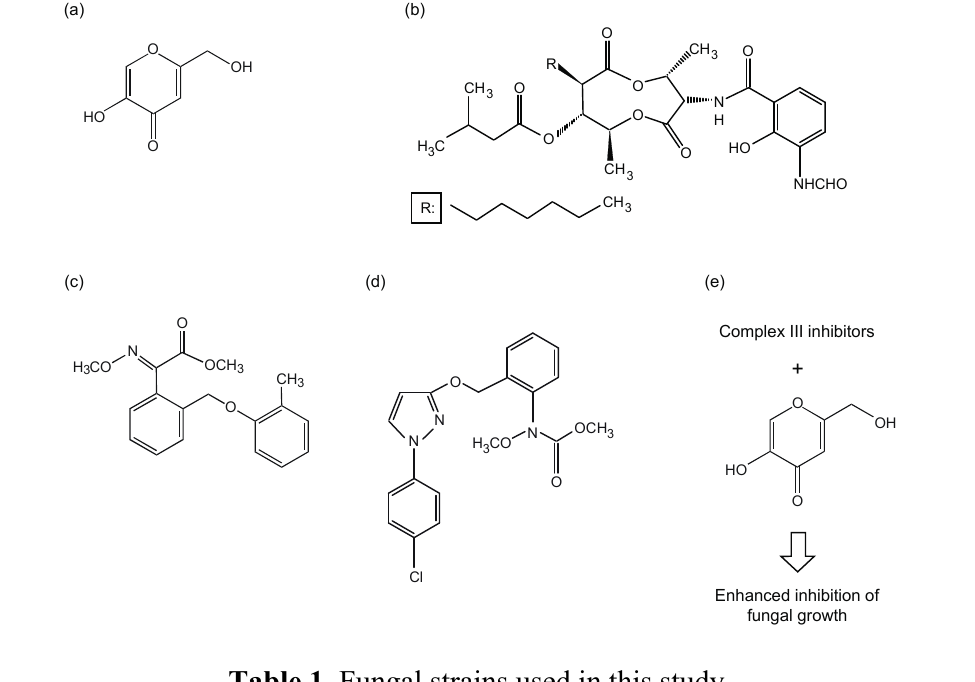
Table 1. Fungal strains used in this